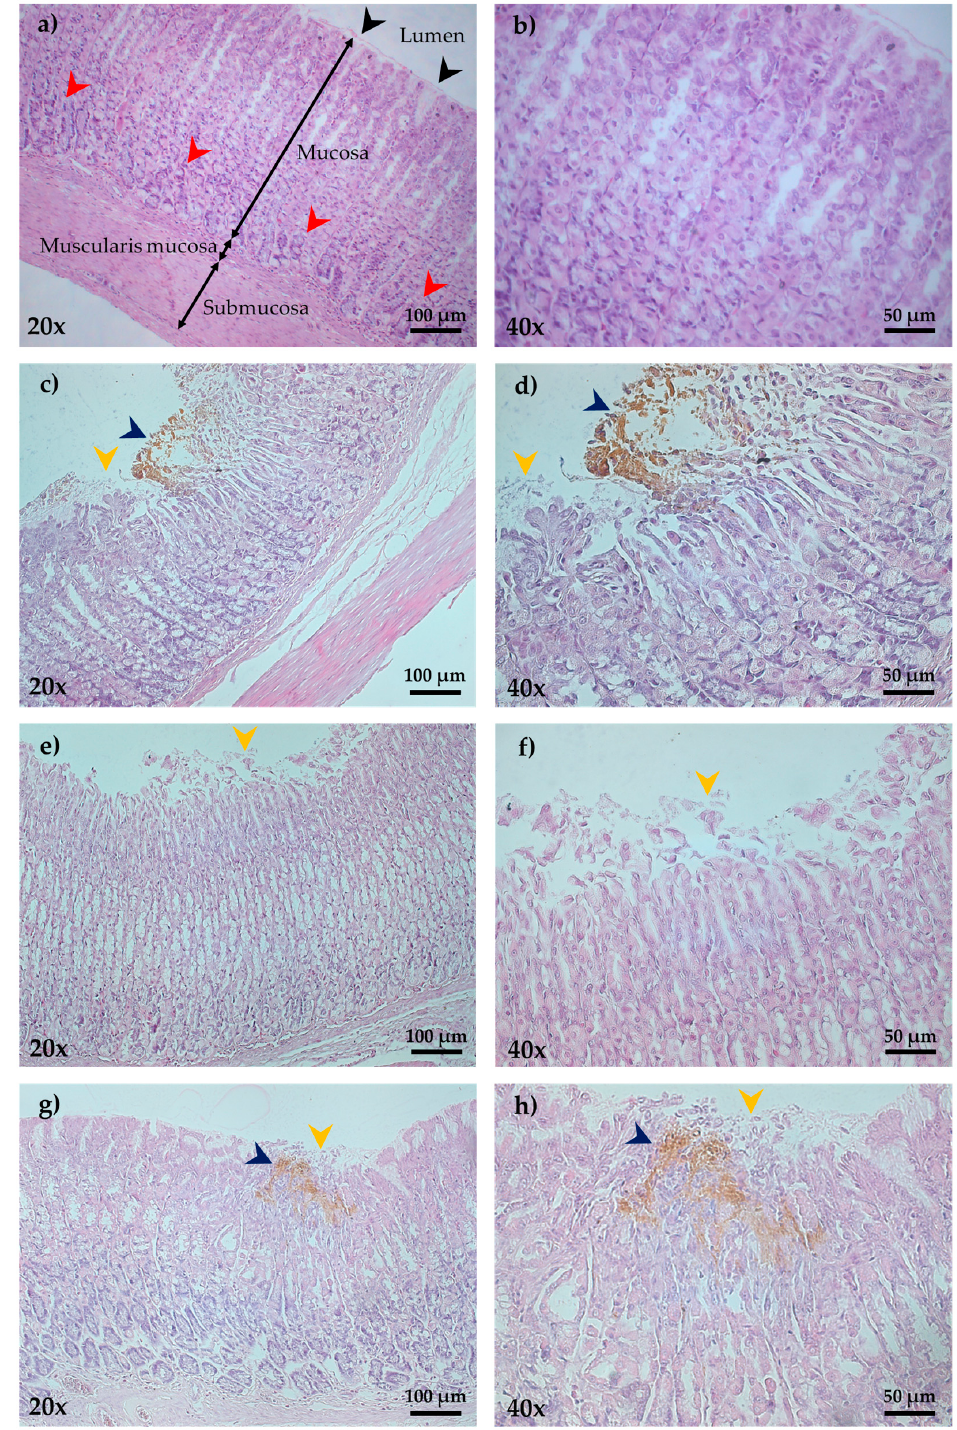
Figure 3. H and E staining of gastric mucosa of rats in the IND-induced gastric ulcer model (magnifi- cation at 20 × and 40 × ). ( a , b ) Control, shows normal aspect of the lumen, mucosa, muscularis mucosa, and submucosa strata; ( c,d ) IND 40 mg/kg, shows severe hemorrhagic necrosis with leukocyte infil- trate (dark blue arrowheads) and erosion of the surface epithelial cells (orange arrowheads); ( e,f ) CTD 100 mg/kg + IND 40 mg/kg, shows erosion of the surface epithelial cells (orange arrowheads); ( g,h ) PhyEx 400 mg/kg + IND 40 mg/kg, shows moderate hemorrhagic necrosis (dark blue arrowheads) and erosion of the surface epithelial cells (orange arrowheads). The region of the epithelium is indicated by black arrowheads while region of the lamina propria is indicated by red arrowheads